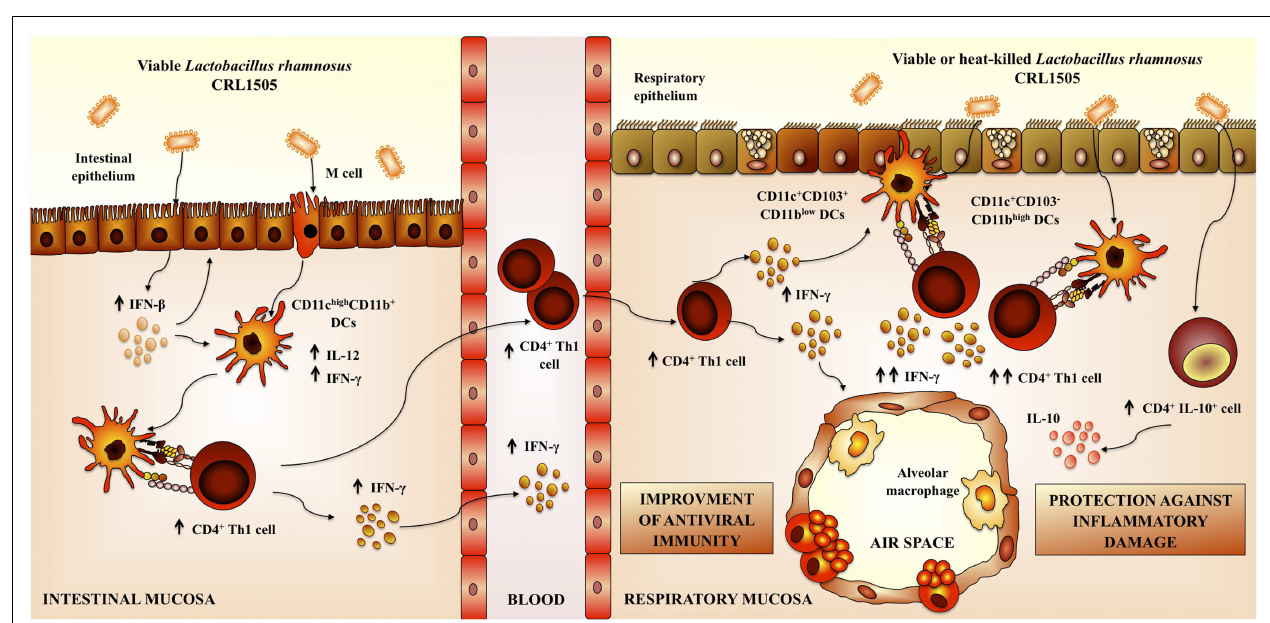
FIGURE 4 | Proposed mechanism for the immunoregulatory effect of Lactobacillus rhamnosus CRL1505 on respiratory anti-viral immune responses and resistance against respiratory syncytial virus